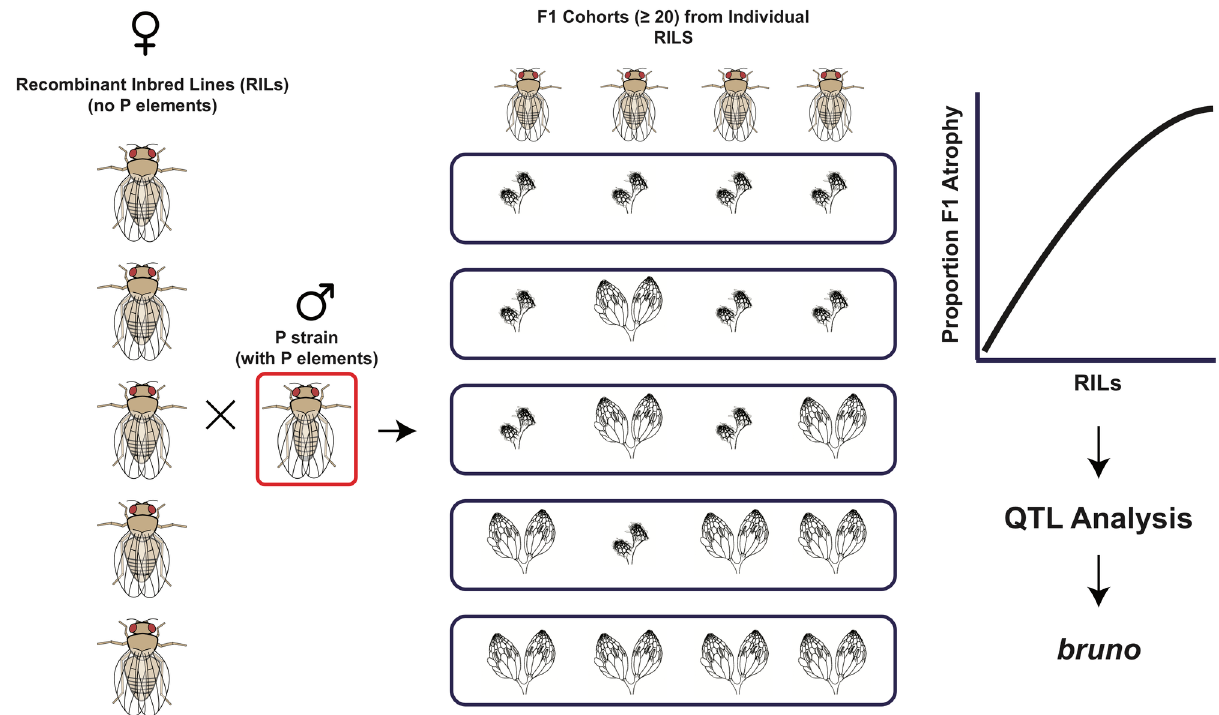
Fig 2. QTL analysis reveals variation in bruno mediates natural tolerance to P element–induced gonadal atrophy. Natural variation in resistance to hybrid dysgenesis was identified using a large number of RILs from the DSPR. A key feature of the DSPR is that it was constructed from strains that lack P element insertions and, hence, also lack P element piRNAs. Multiple females from each RIL were crossed to males of a P strain with a strong capacity to induce dysgenesis. Variation in tolerance to P element–induced atrophy was revealed by performing crosses at a mildly permissive temperature. This experiment revealed a tremendous amount of variation: some strains exhibit no gonadal atrophy, while others exhibit complete gonadal atrophy. Using this variation in a QTL analysis, segregating variation at the bruno gene was found to be an important determinant of tolerance to P element–induced sterility in the DSPR. DSPR, Drosophila Synthetic Population Resource; QTL, quantitative trait locus; RIL, recombinant inbred line.